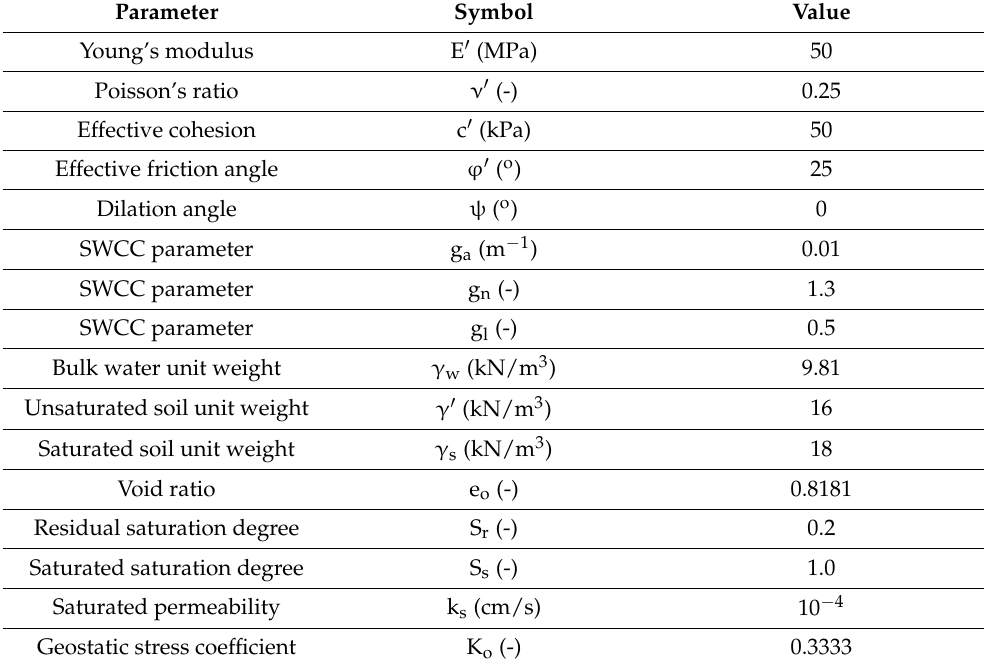
Table 2. Physical and hydro-mechanical parameters of the simulated soil material. Parameter Symbol Value Young’s modulus E (cid:48) (MPa) 50 Poisson’s ratio ν (cid:48) (-) 0.25 Effective cohesion c (cid:48) (kPa)